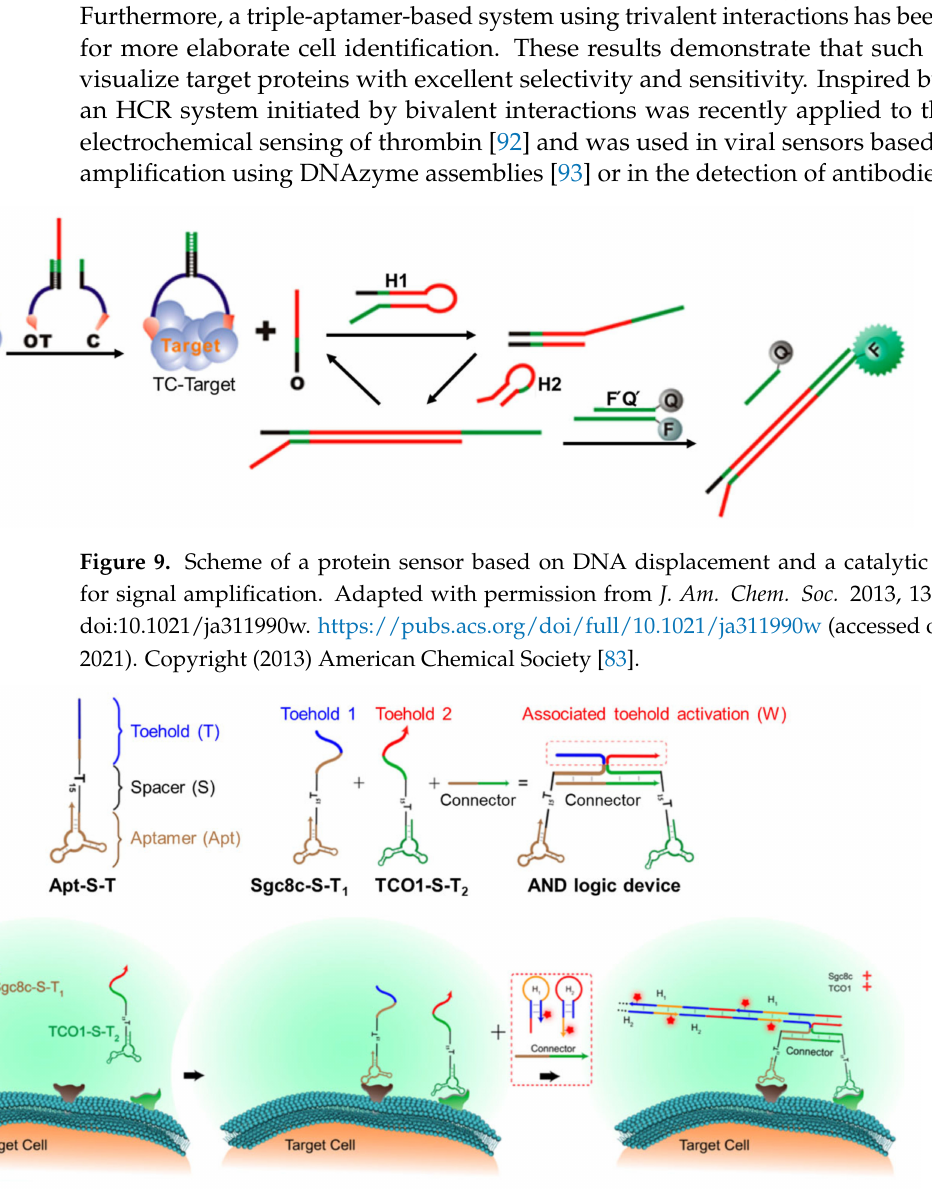
Figure 10. Scheme of a cancer cell identification system based on bivalent interactions between cells and aptamers. Fluorescence signaling is enabled by a hybridization chain reaction (HCR). Adapted with permission from J. Am. Chem. Soc. 2019, 141, 12738–12743, doi:10.1021/jacs.9b05470. Copyright (2019) American Chemical Society